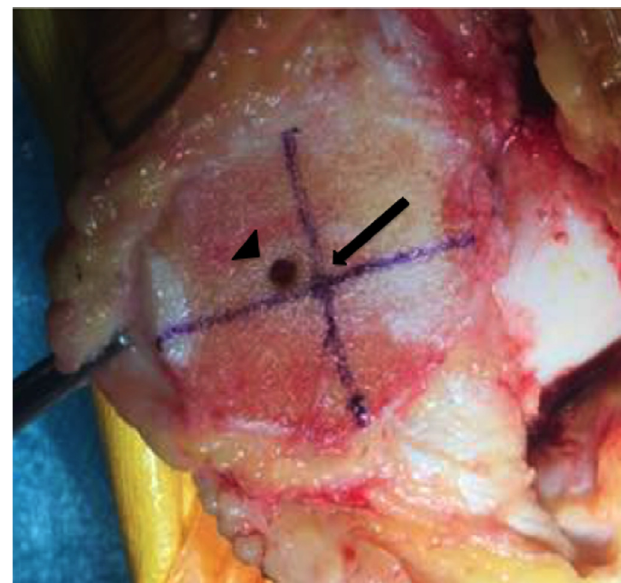
Figure 7. Identi fi cation of the anatomic center of the patellar cut and comparison with respect to the